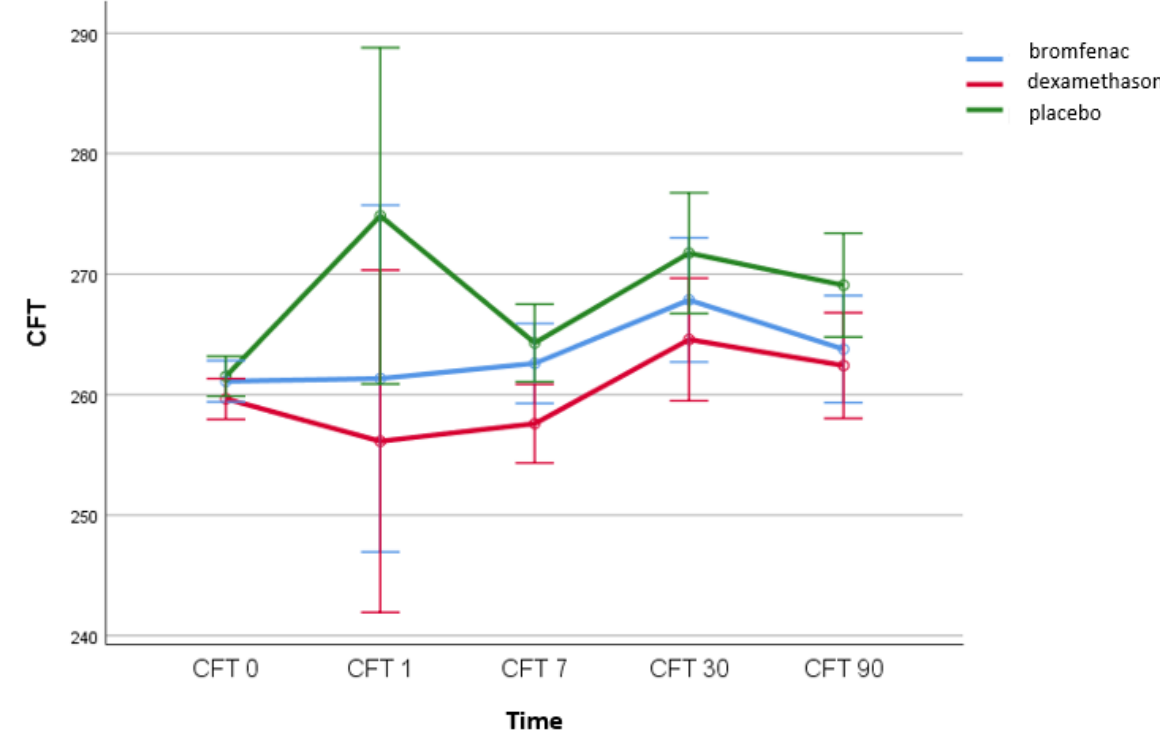
Figure 4. No interaction effect was observed between the time of CFT measurement ( µ m) and different groups ( F (2.53, 108.74) = 1.032, p = 0.373); bromfenac group n = 30; dexamethasone group n = 30; placebo group n = 30; CFT, central foveal subfield thickness; CFT 0, central foveal subfield thickness on the day of the surgery; CFT 1, central foveal subfield thickness on first postoperative day; CFT 7, central foveal subfield thickness seven days after surgery; CFT 30, central foveal subfield thickness 30 days after surgery; CFT 90, central foveal subfield thickness 90 days after surgery.